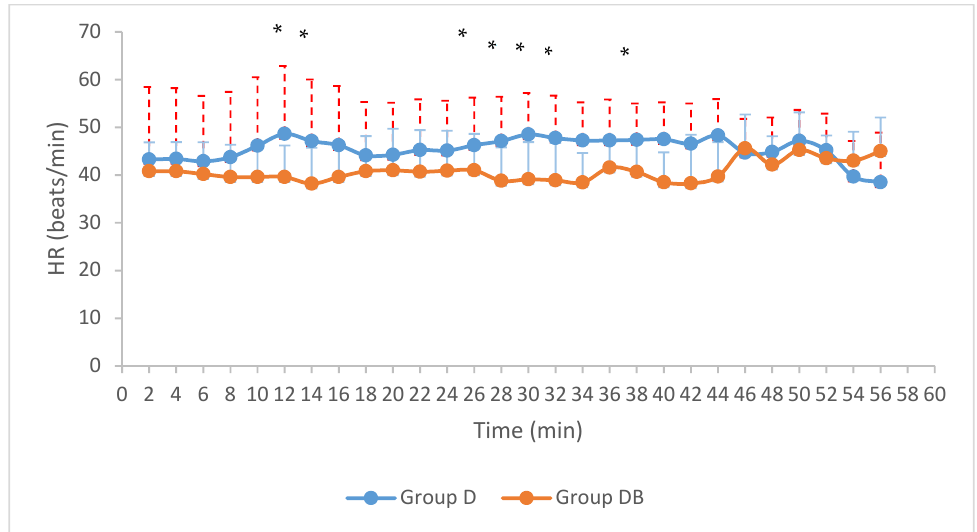
Figure 1. Vertical bar chart showing anaesthesia duration, patient preparation, surgical time and recovery time in the two groups. All the variables are expressed in function of time (minutes on the Y axis). Statistical differences are expressed by the same letter on the bars (a: p = 0.016; b: p = 0.003).